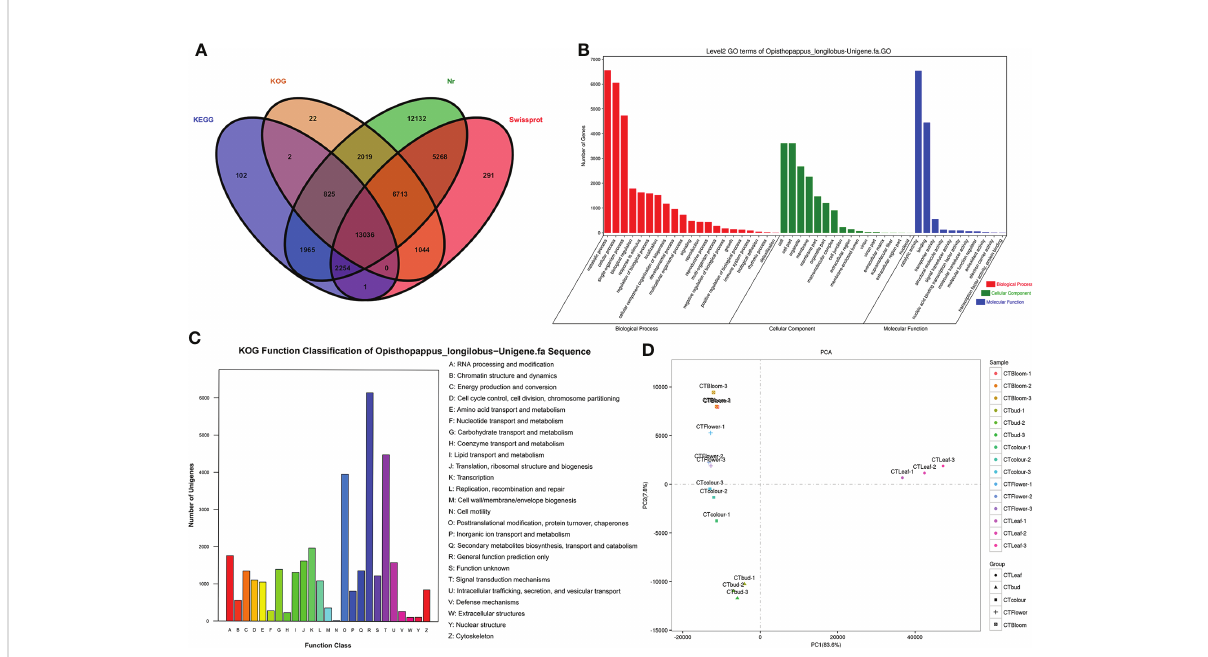
FIGURE 3 Opisthopappus longilobus transcriptome analysis results (A) Venn diagram of unigenes functionally annotated according to four major databases. (B) Histograms of the GO classi fi cations. The unigenes were divided into the three main GO categories (biological process, cellular component, and molecular function). The x-axis lists the GO terms in the three categories, whereas the y-axis presents the number of unigenes. (C) KOG classi fi cation map. A total of 35,012 sequences with KOG classi fi cations in 25 categories are presented. (D) Results of the principal component analysis of the O. longilobus